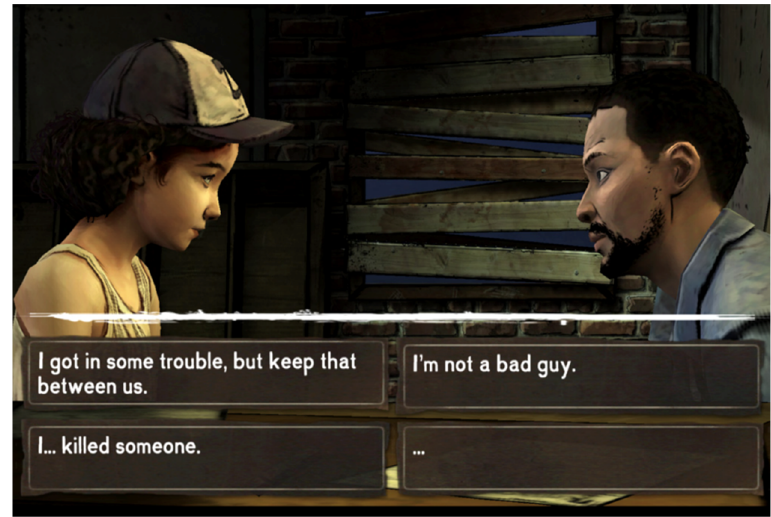
Figure 2. Dialog choices for the player-character, Lee (right), in conversation with Clementine (left), including the silent option (indicated by the ellipsis in lower right) and white timer bar in Telltale Games’ The Walking Dead .